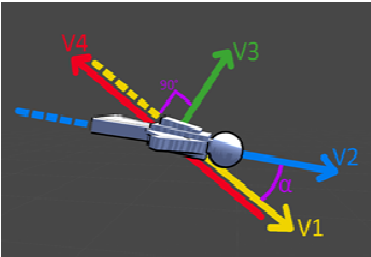
Figure 4. Vectors of forces of the glider: V1 is the motion vector, V2 is the glider direction vector, V3 is the lifting force vector, V4 is the resistance force vector, and α is the attack angle between the direction of the glider and the direction of movement.